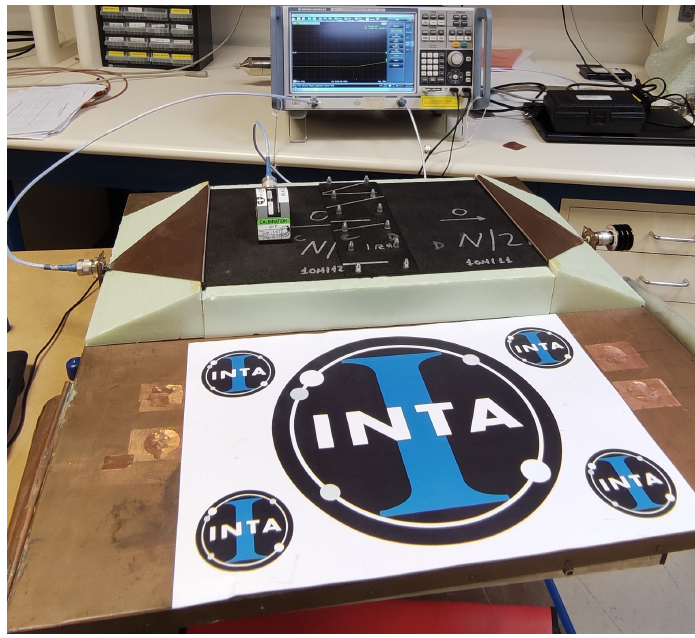
Figure 7. Microstrip transmission line measurement